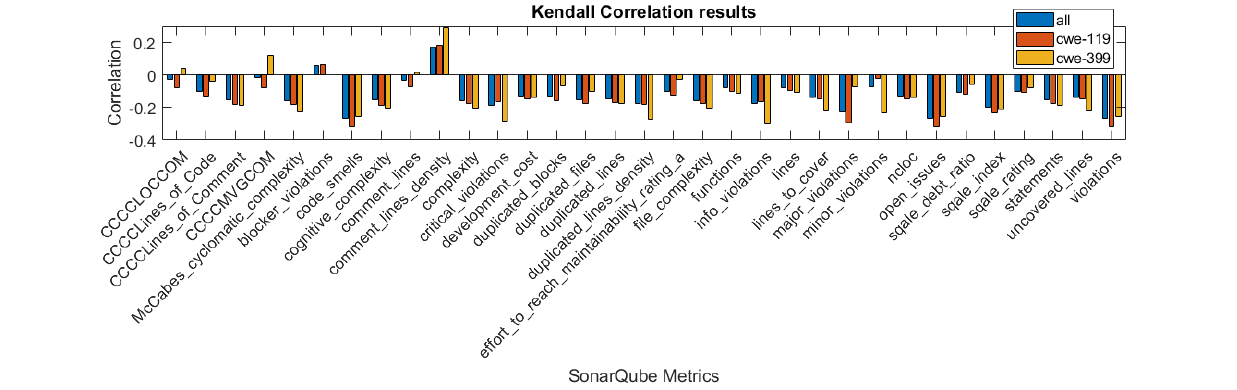
Figure 3. Kendall correlation values for the features obtained using different subsets of a dataset.